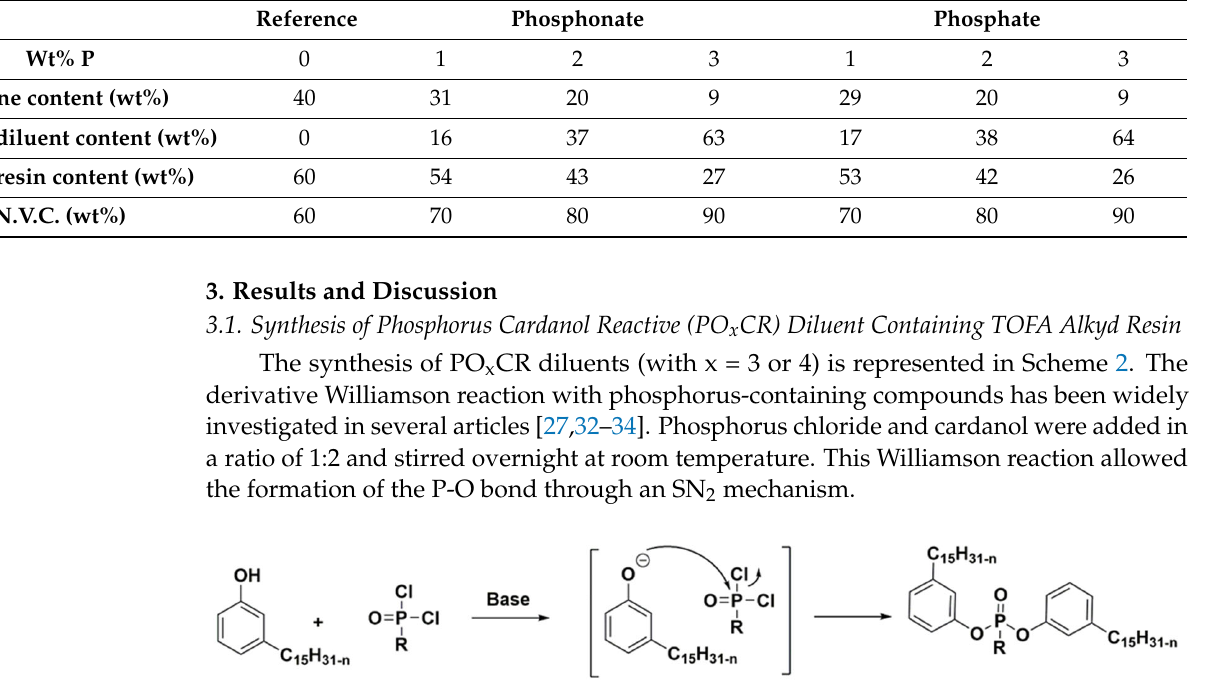
Table 1. Composition of phosphorylated cardanol reactive diluent alkyd resins at the same viscosity (5.3 Pa.s).